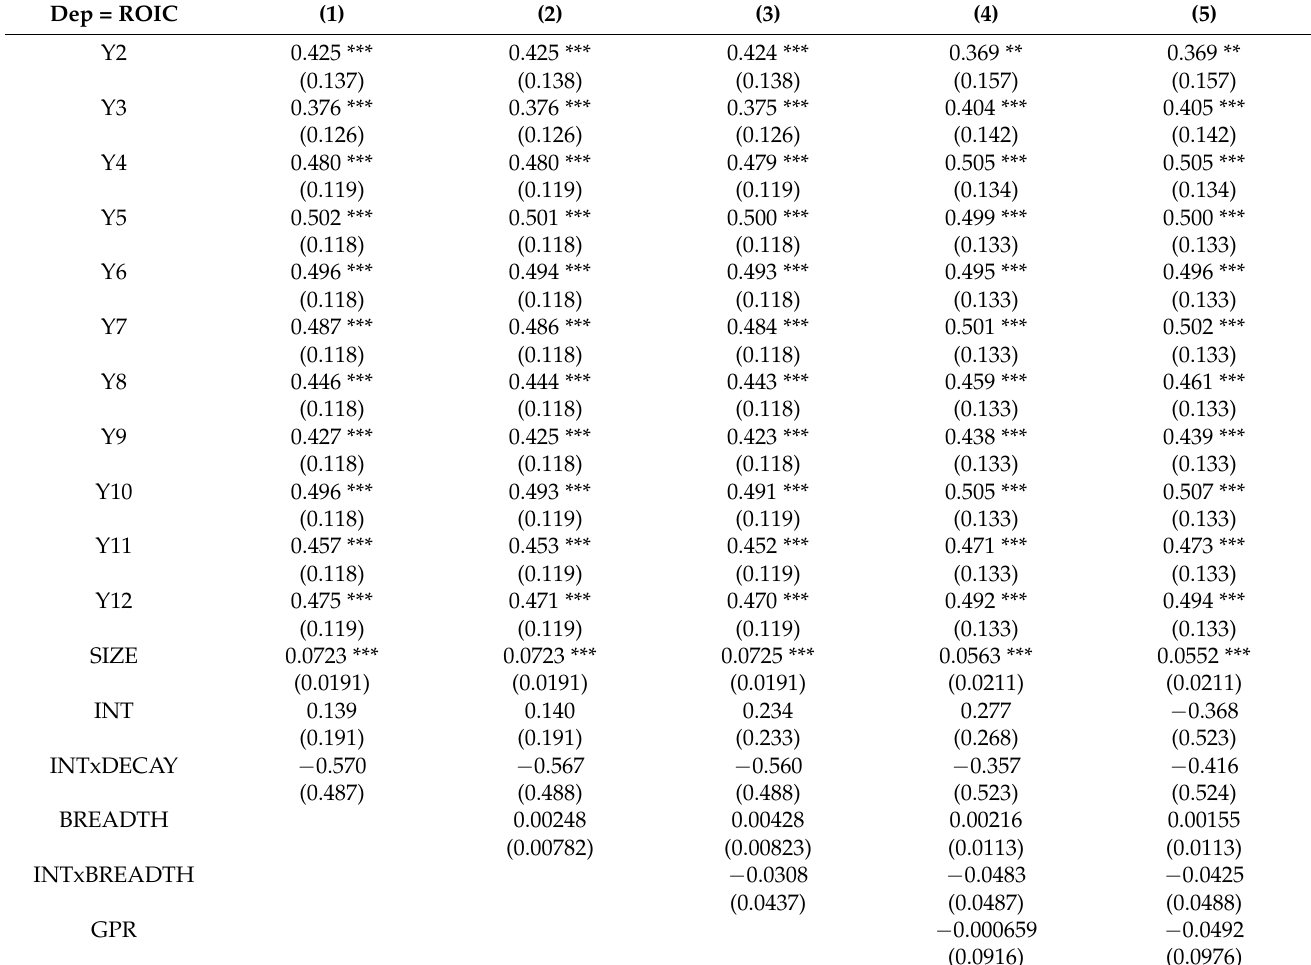
Table A1. Effect of breadth and GPR on firm Return on Invested Capital